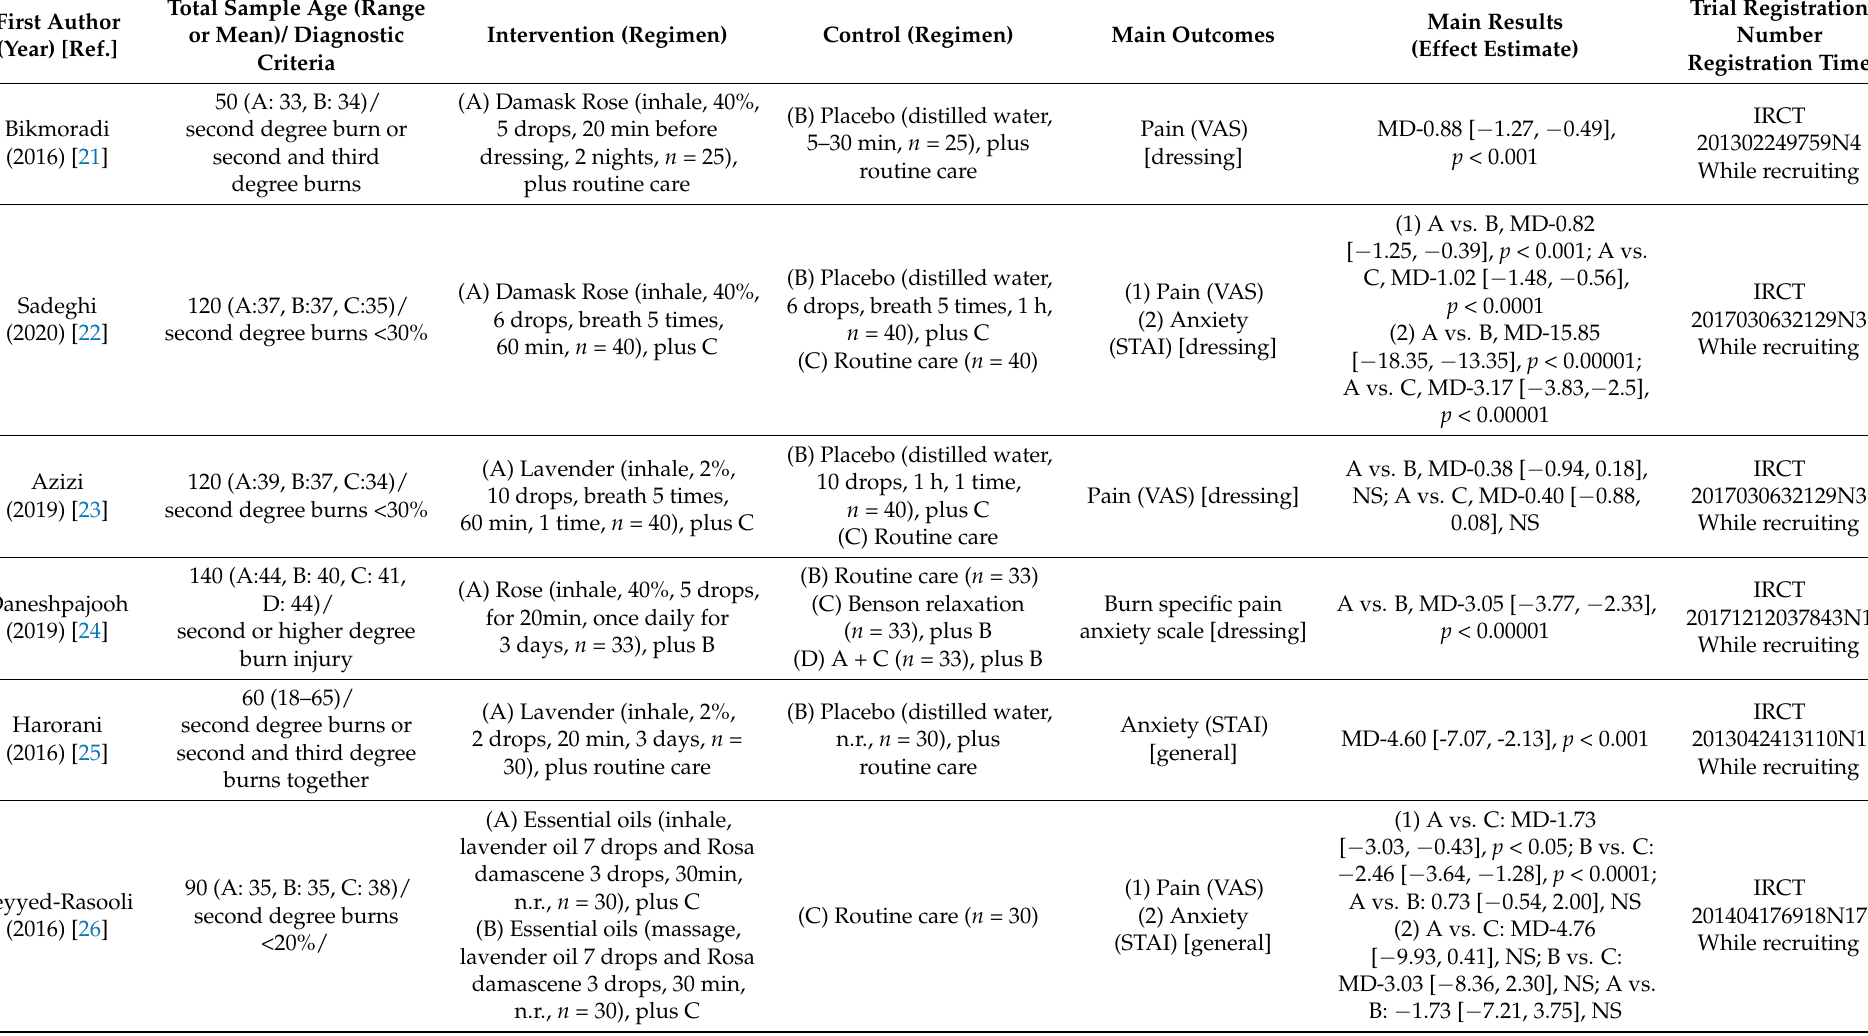
Table 1. Summary of randomized clinical studies of aromatherapy for managing symptoms in patients with